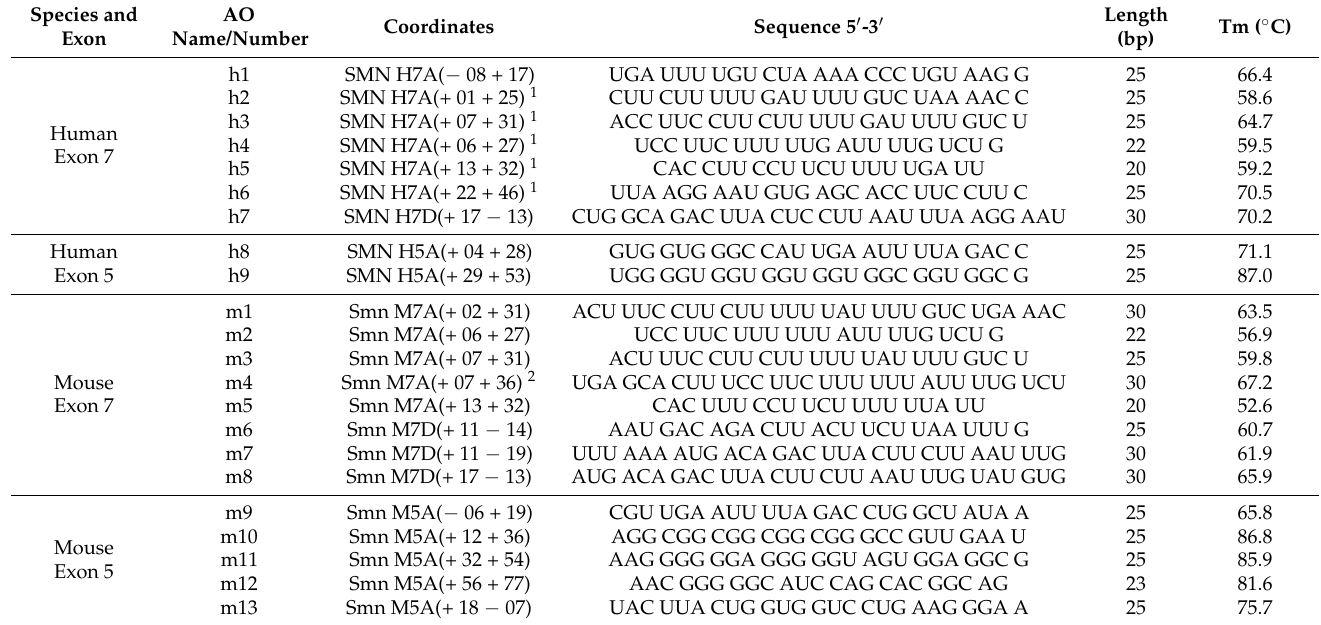
Table 1. Sequences and binding coordinates of exon skipping AOs designed for the human SMN and mouse Smn transcripts. The AO length and melting temperature (Tm) of the 2 (cid:48) - O -methyl AO sequence is listed. Species and